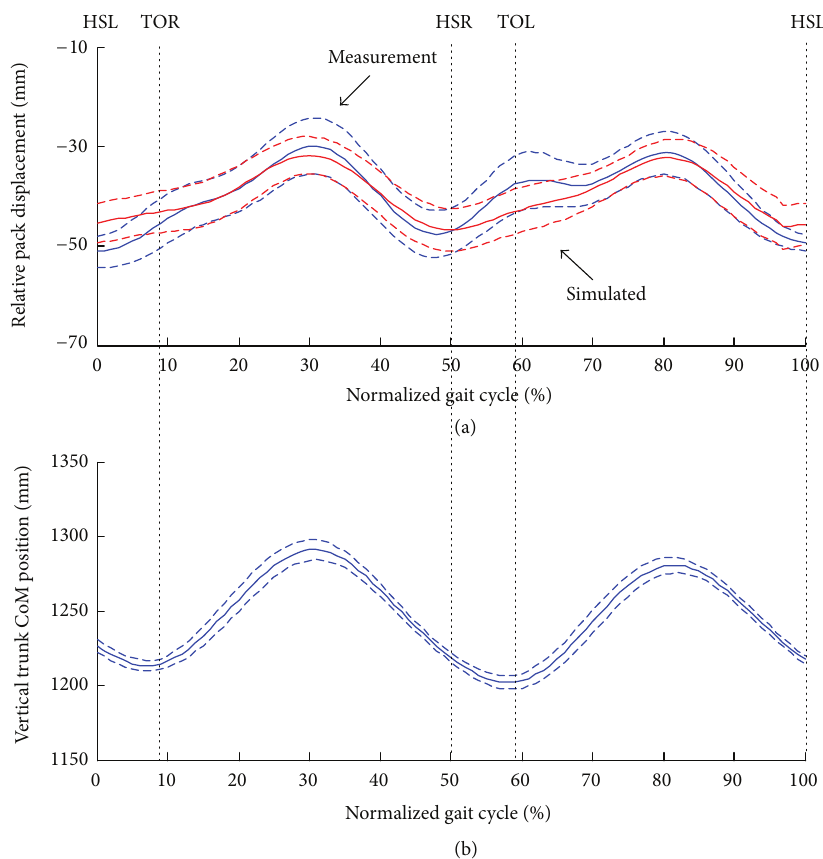
Figure 8: The simulated relative pack displacement along the back (mean (solid red line) ± one standard deviation (dashed red lines), (a)), compared with measured data (mean (solid blue line) ± one standard deviation (dashed blue lines), (a)), for six repeated trials for one subject (age: 28 yrs, weight: 71.8 kg, height: 178cm), and measured vertical trunk CoM displacement (mean (solid blue line) ± one standard deviation (dashed blue lines), (b)). The average walking speed was 1.93 ± 0.03 m/s, and the pack load was 11.5kg. The stance phase for the left limb is from 0 to 59%, and the swing phase is from 59% to 100%. The double support phase is from 0 to 9% and from 50 to 59%.